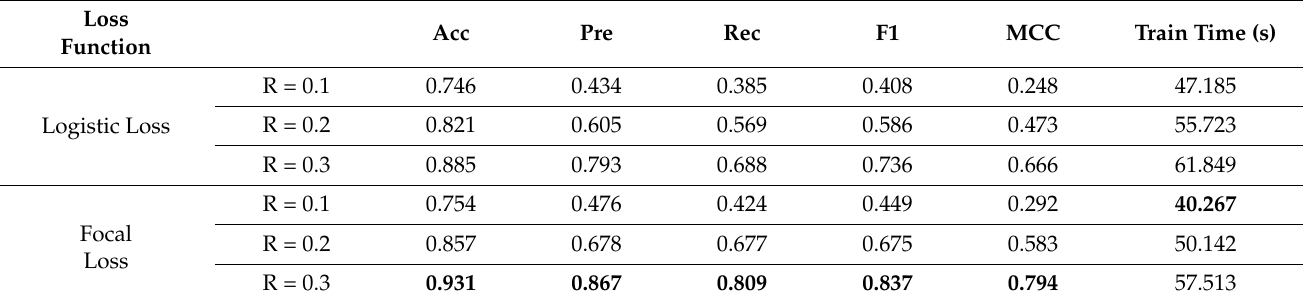
Table 4. Effect of different loss functions on model